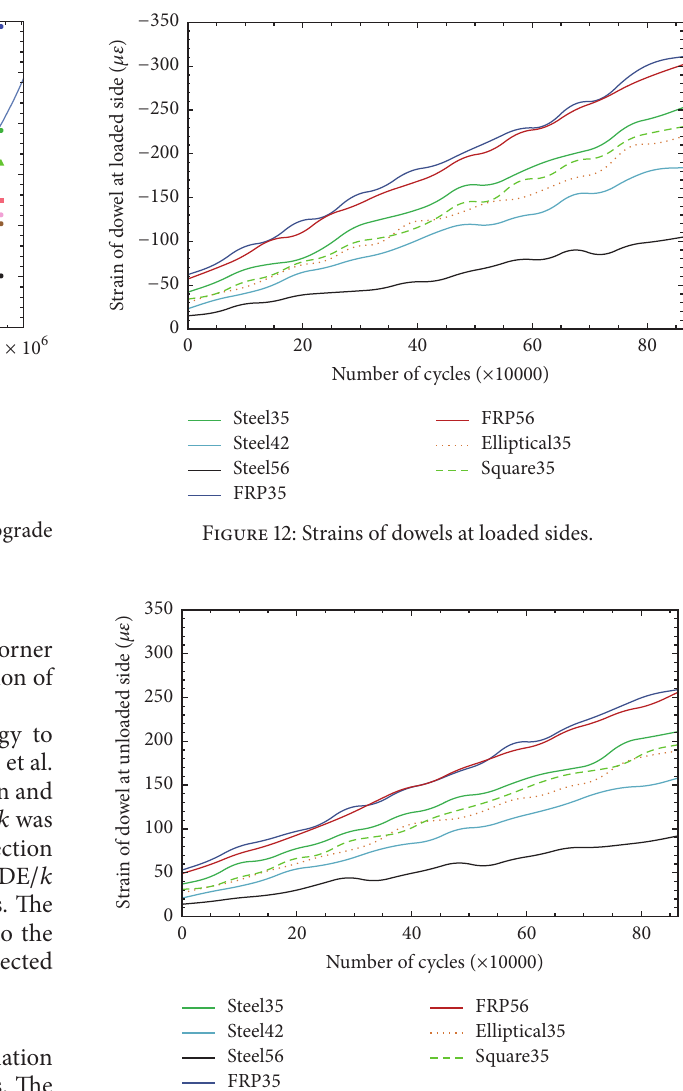
Figure 13: Strains of dowels at unloaded